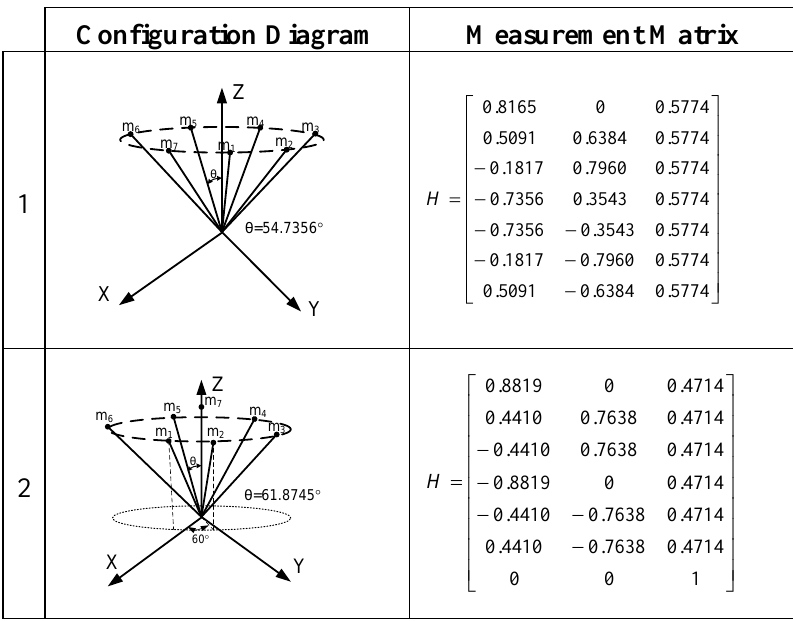
In HH T  for 7  n 3